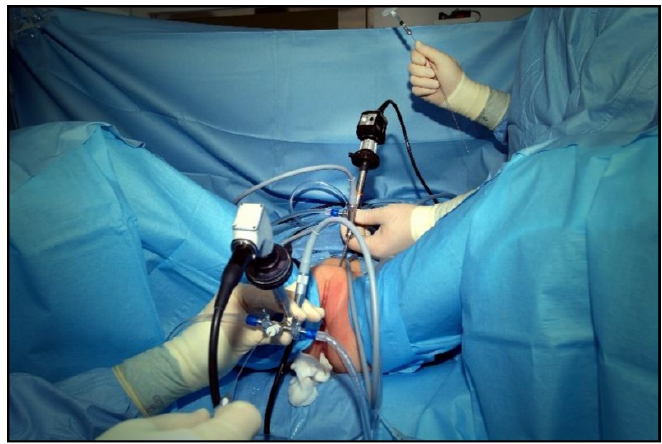
Figure 2. Combined antegrade and retrograde endoscopy.